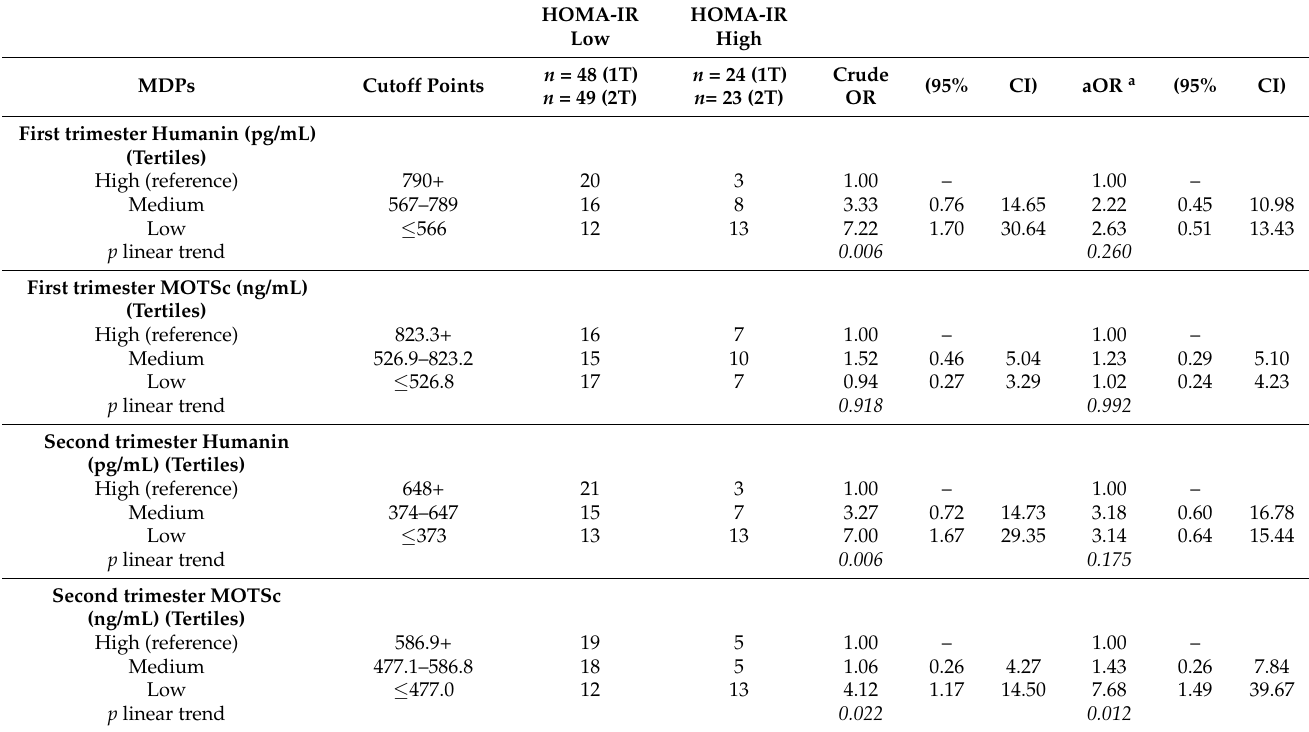
Table 3. Association between levels of mitochondria-derived peptides and the HOMA-IR index during the first and second trimesters of gestation. HOMA-IR